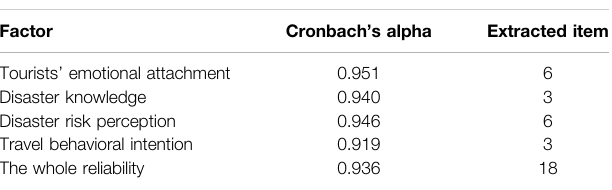
TABLE 3 | Reliability